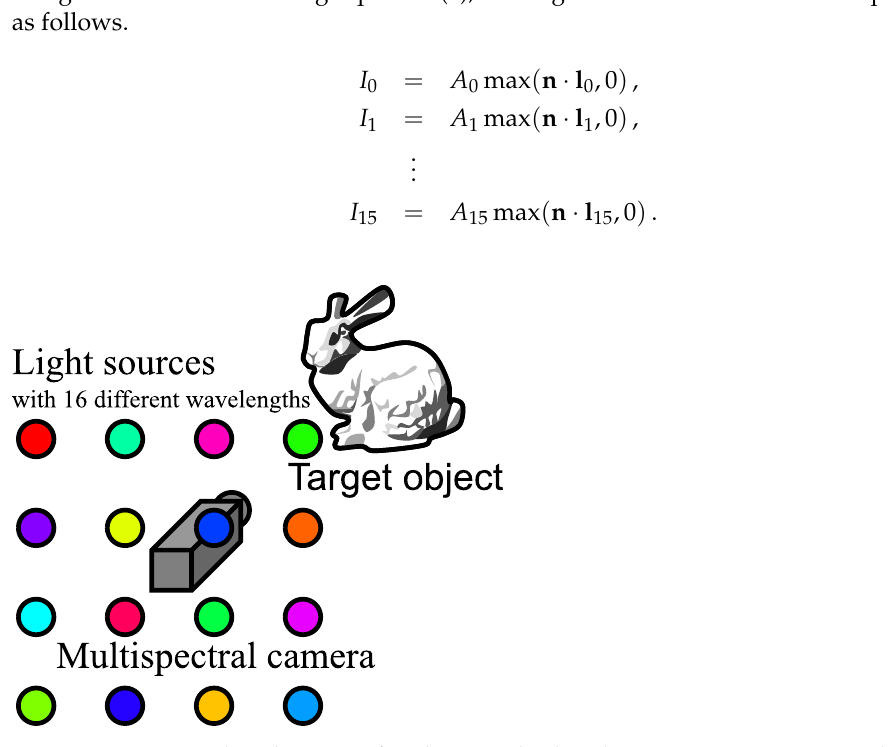
Figure 1. Conceptual explanation of multispectral color photometric stereo. Target object is illu- minated by multiple light sources whose wavelengths are different. One image is taken using the multispectral